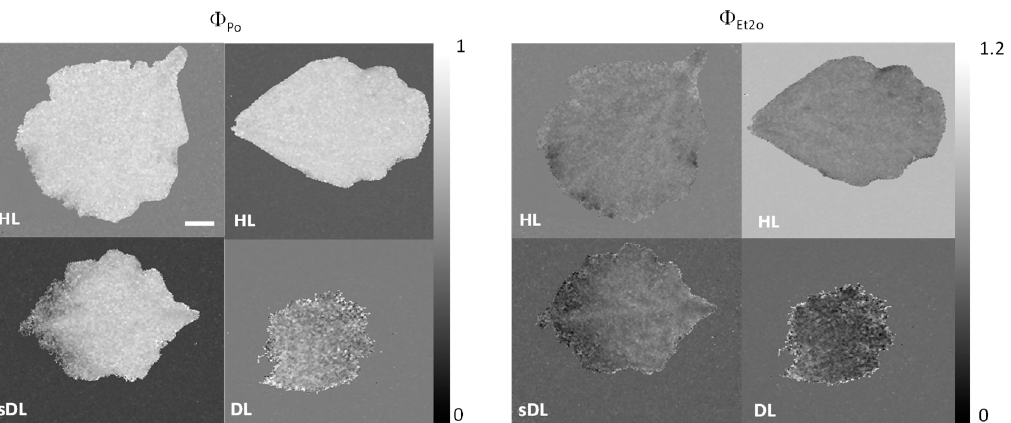
Figure 5. Representative images of the effects of dehydration on OJIP parameters in fully hydrated (HL; RWC~ 90%), semi-desiccated (sDL, RWC ~ 60%), and desiccated (DL, RWC ~ 15–20%) R. serbica leaves. Φ Po ; equals Fv/Fm- maximum quantum yield of primary PSII photochemistry; Φ Et2o , a measure for the quantum yield of the electron transport flux from Q A to Q B . The bar represents 1 cm.